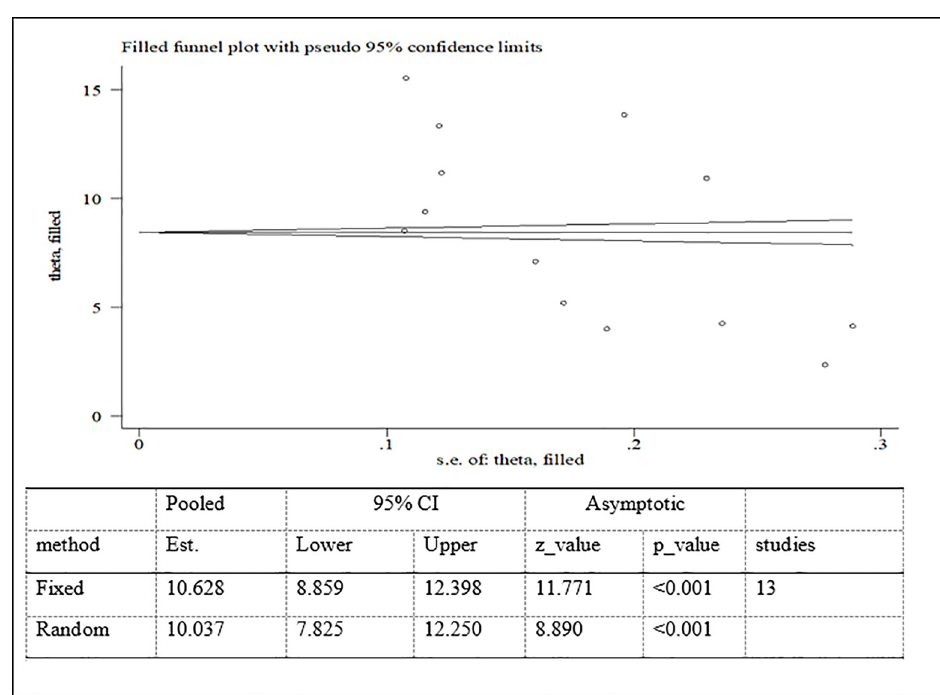
Fig 10. Trim and fill analysis for overweight/obesity among adolescent in Ethiopia.